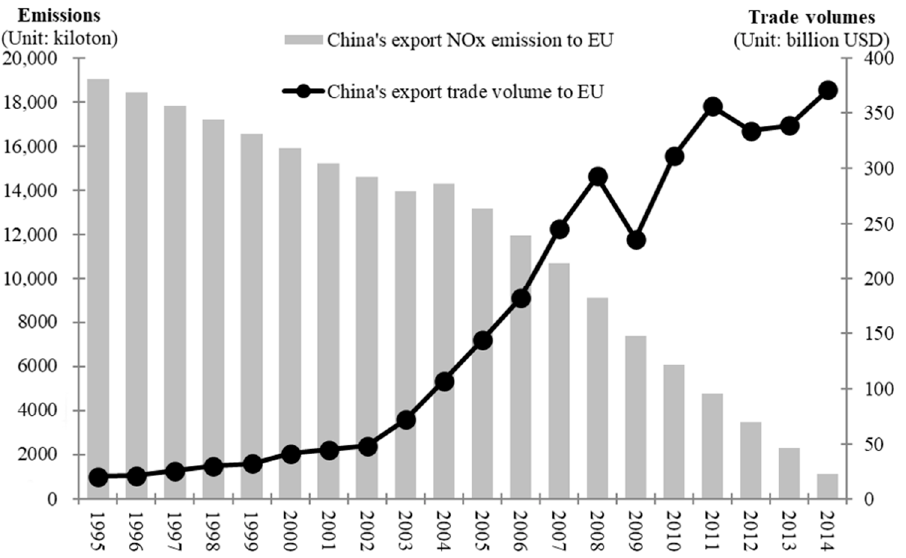
Figure 1. Export volume from China to the EU and the embodied NO x emissions (Left Axis Unit: kiloton; Right Axis Unit: billion USD. Data Sources: UNCTAD Database).